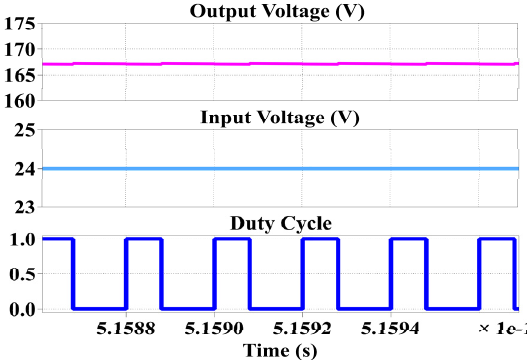
Figure 8. Output Voltage at 24 V input and D = 0.4.